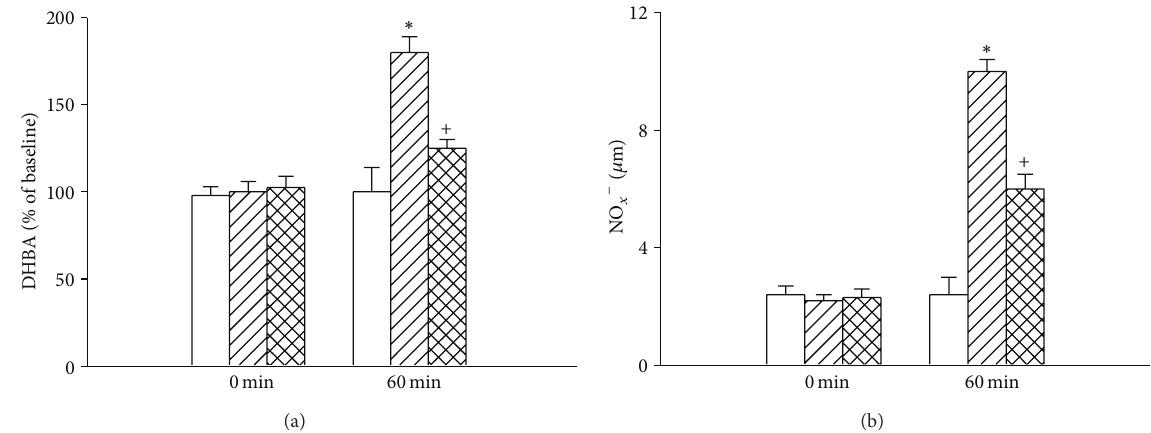
Figure 3: Values of hypothalamic levels of dihydroxybenzoic acid (DHBA) and nitric oxide metabolites (NO 𝑥− ) for the (NTDR + V) group (white bar), (HSDR + V) group (dashed bar), and (HSDR + H) group (crossed bar). The values were obtained at 0 or 60 min after the initiation of heat exposure in heatstroke rats or the equivalent times in the (NTDR + V) group. ∗ 𝑃 < 0.01 in comparison with the (white bar) group; + 𝑃 < 0.05 in comparison with the (dashed bar) group. Bars were the mean ± SD of eight rats for each group. See the legends of Figure 1 for explanation of the abbreviations.